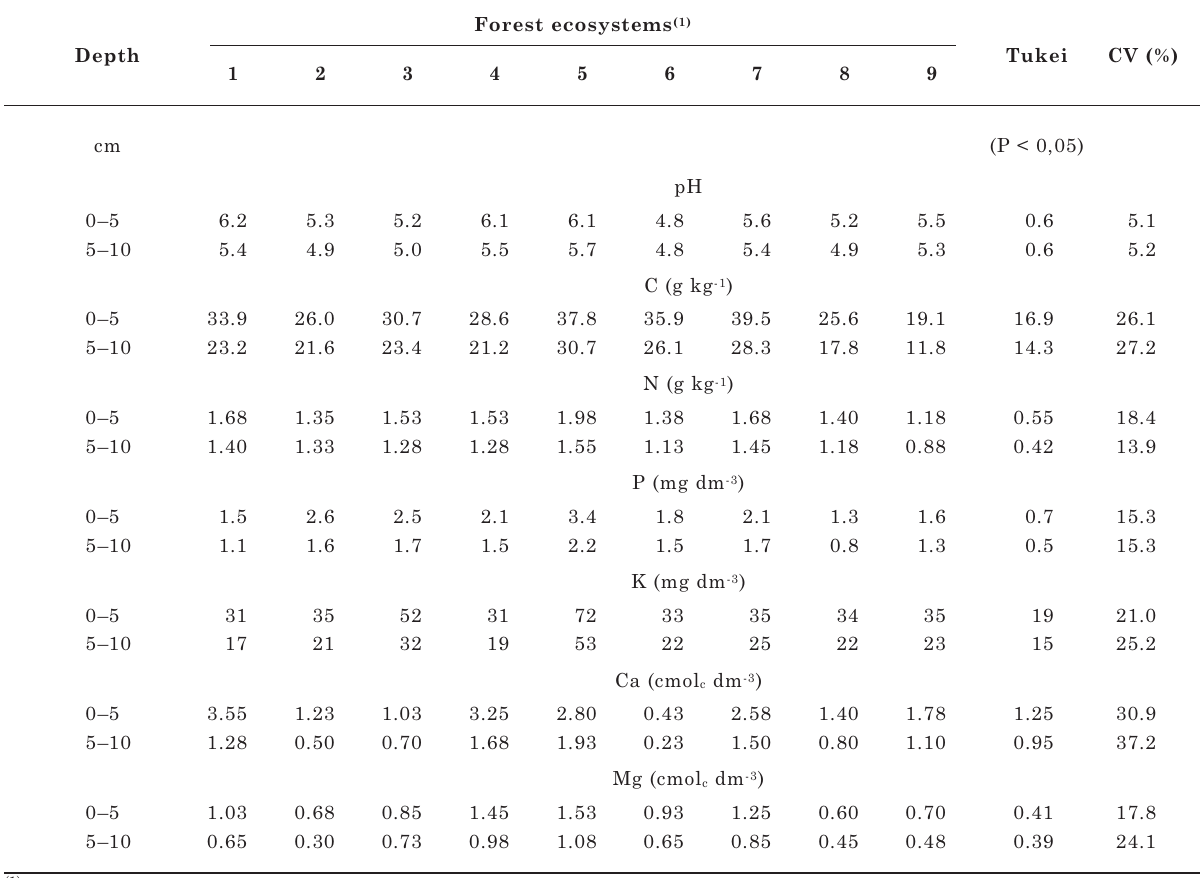
Table 8. pH values, and soil C, N, P, K, Ca and Mg levels under different forest